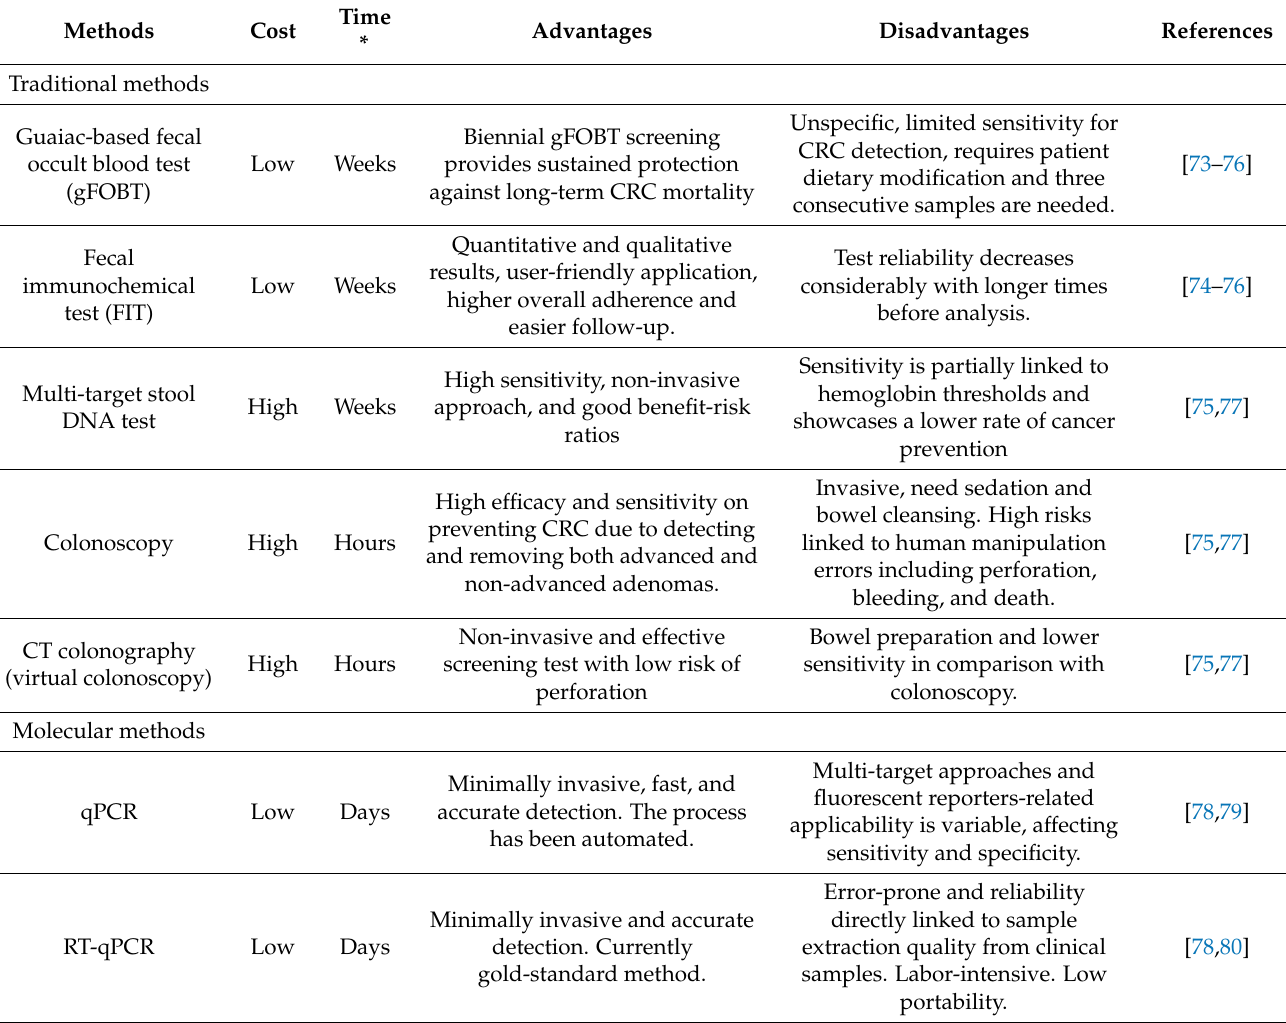
Table 1. Current traditional clinical methods and molecular methods for CRC diagnosis. Methods